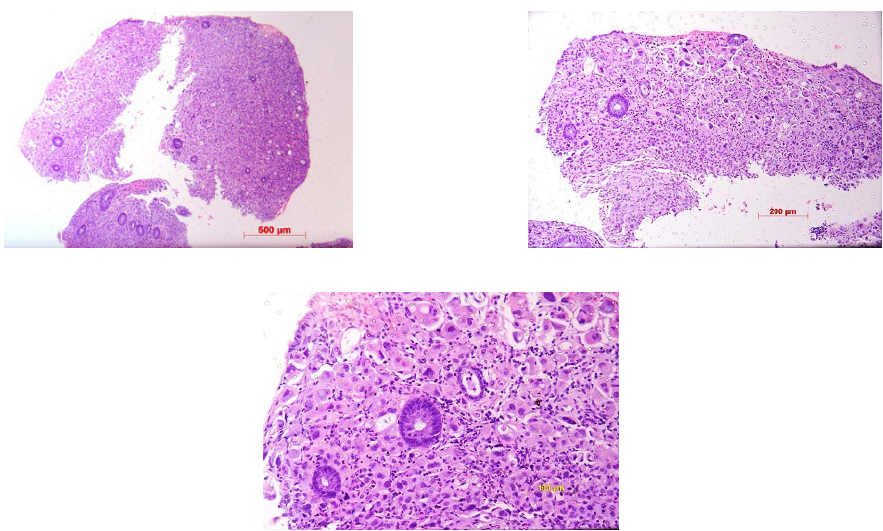
Figure 2. Histological evaluation reveals poorly differentiated malignancy invading colonic and rectal mucosa.